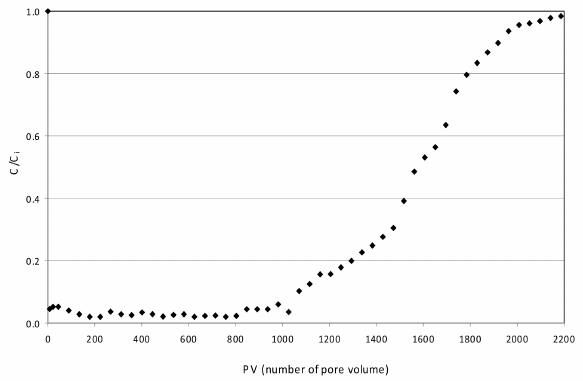
Figure 20. Normalized Pb 2+ concentration in the effluent (C/C i ) vs. number of exchanged pore volumes (PV) of MgO_nZVI.